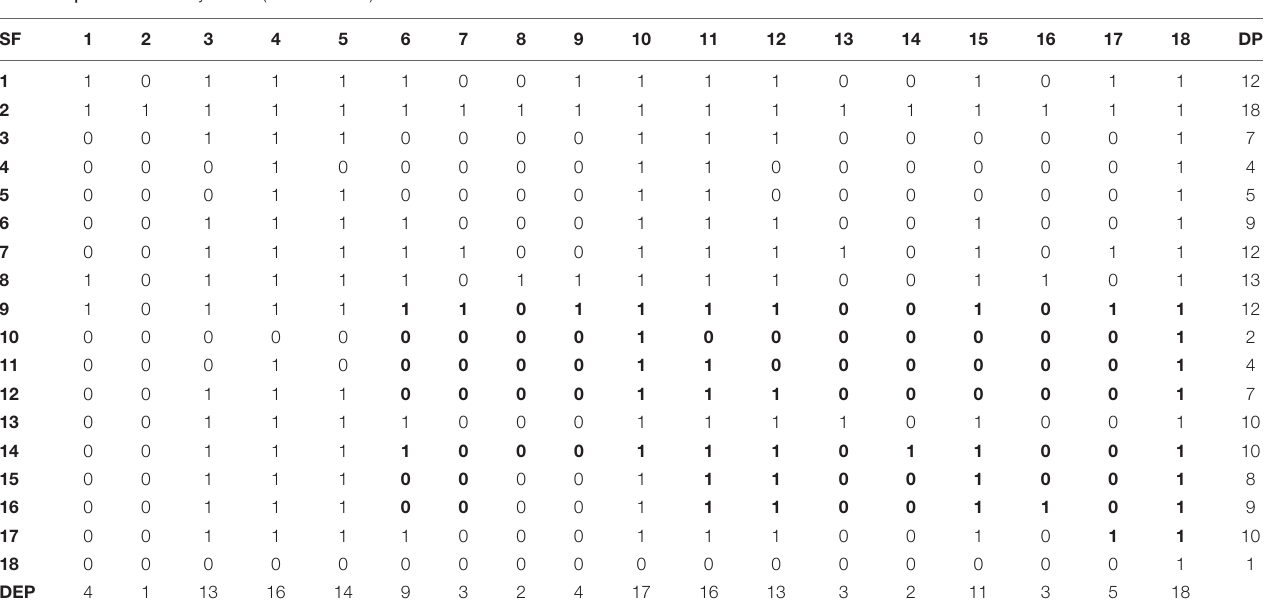
TABLE 3 | Final reachability matrix (conical